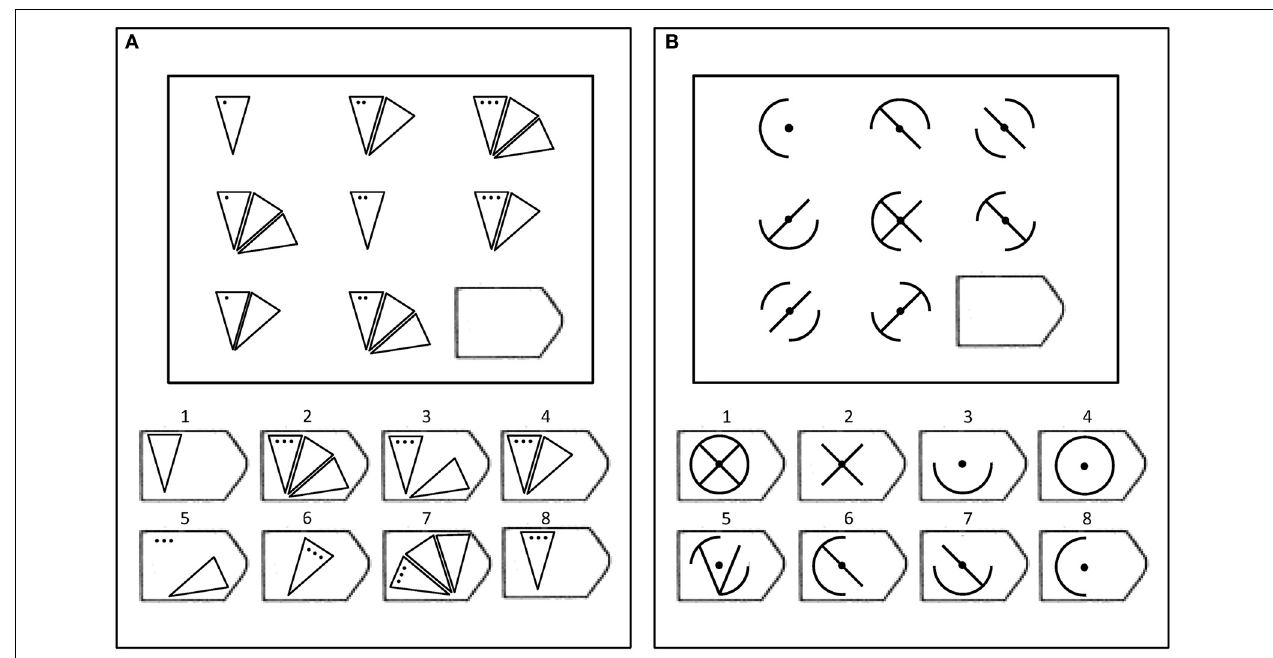
FIGURE 1 | Two examples of matrices like those in the Raven’s test. (A) Example of an item containing a pairwise incremental rule and a distribution of three permutation rule. (B) Example of an item containing a constant rule and a distribution of two (XOR) rule.